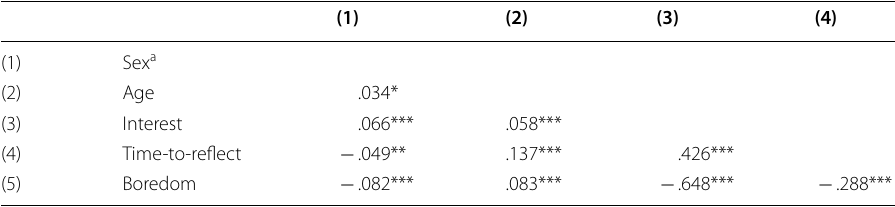
Table 1 Intercorrelations between variables